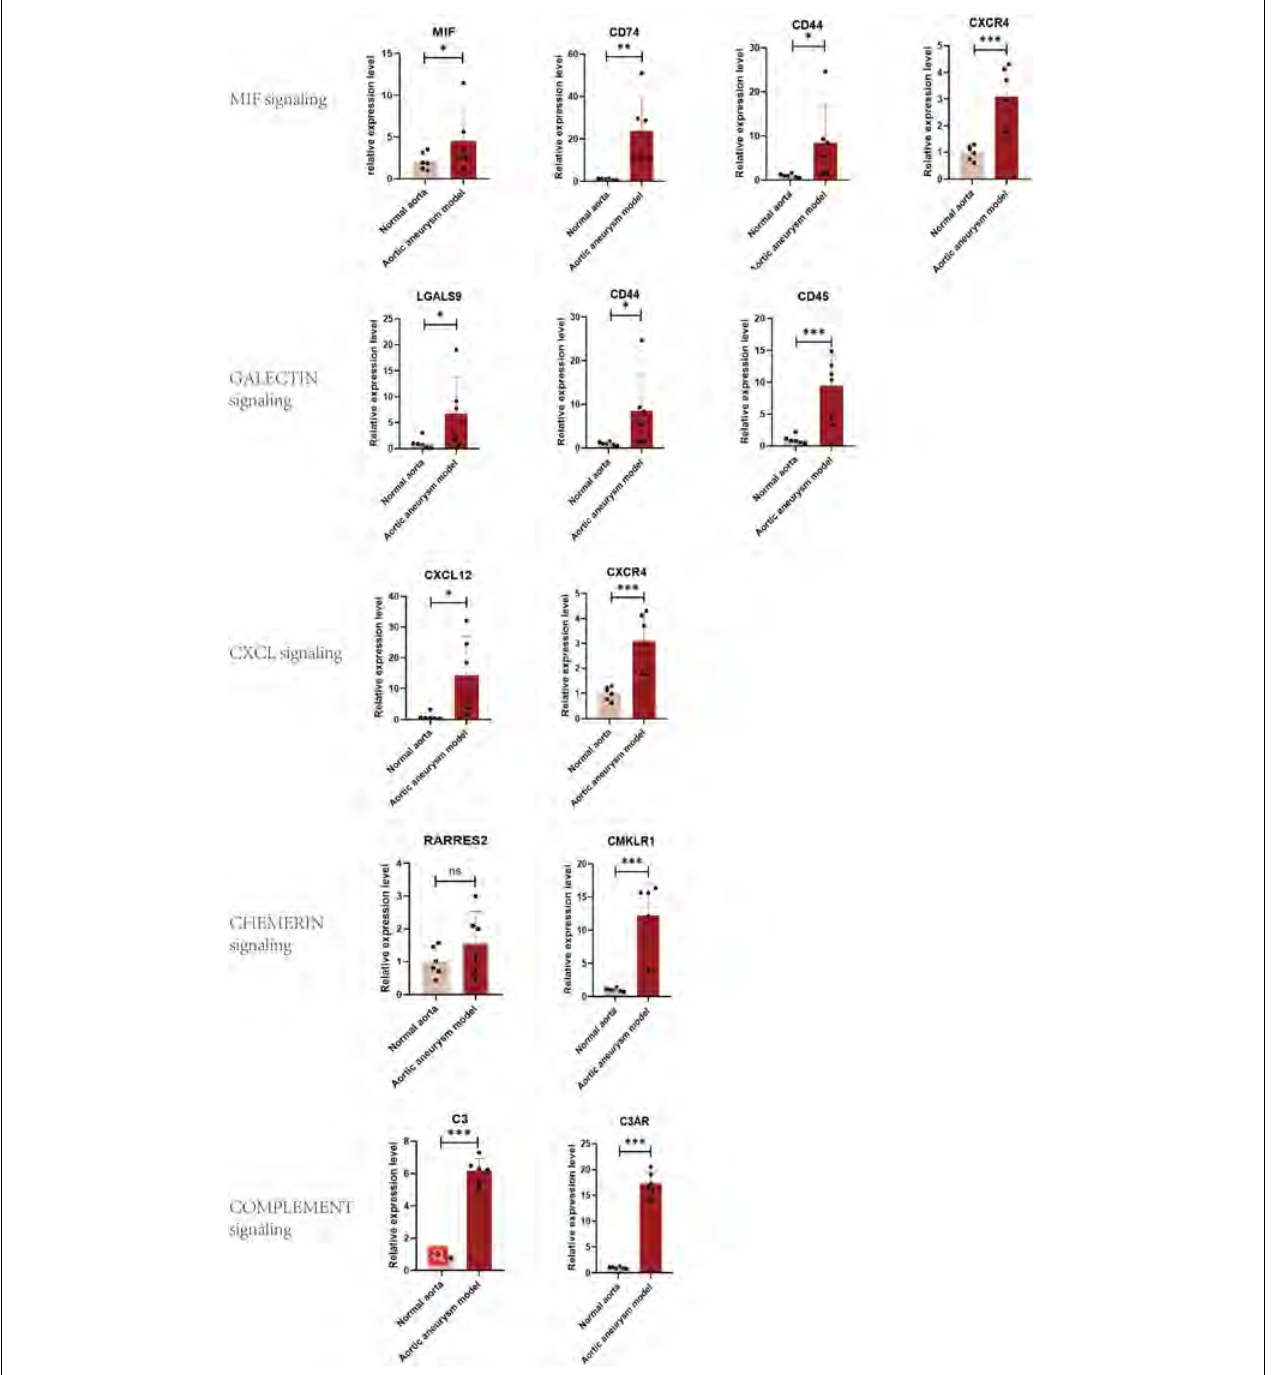
FIGURE 7 | Validation of the expression level of significant ligand–receptor pairs of signaling MIF, galectin, CXCL, chemerin, and complement by qPCR. * P < 0.05, ** P < 0.001, *** P < 0.0001.